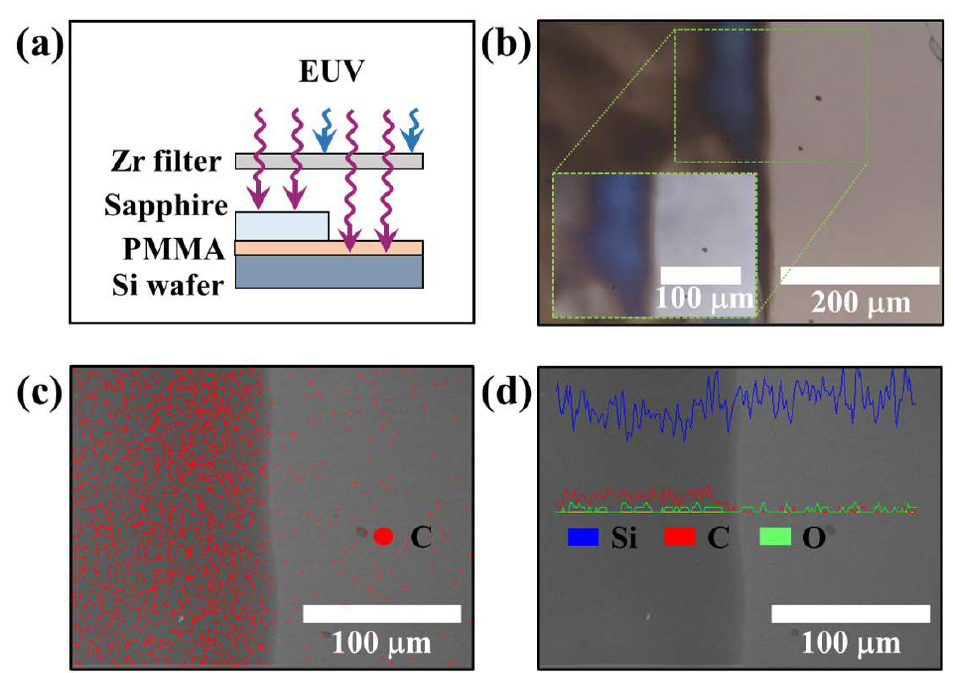
Figure 9. Lithography of polymethyl methacrylate photoresist was performed using extreme ultraviolet light produced through C-beam. ( a ) Schematic view of the extreme ultraviolet light with 150 nm Zr filter. The 150 nm Zr filter only transmits EUV light. Sapphire was used as a photomask, and polymethyl methacrylate was used as a photoresist. ( b ) Optical microscope image after exposure and develop. ( c ) Mapping of carbon elements measured with energy dispersive X-ray analysis. ( d ) Line profile of the element composition measured with energy dispersive X-ray analysis.